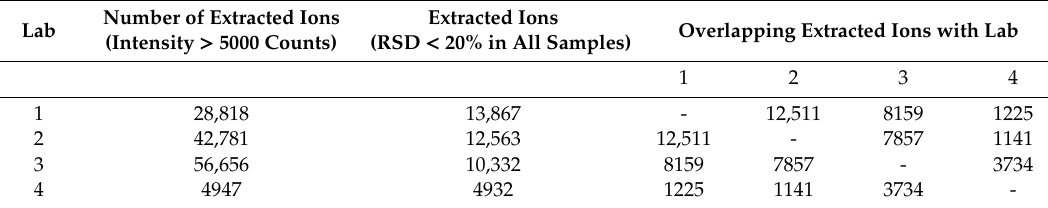
Table 2. LC-MS Interlaboratory metabolite coverage and overlap.